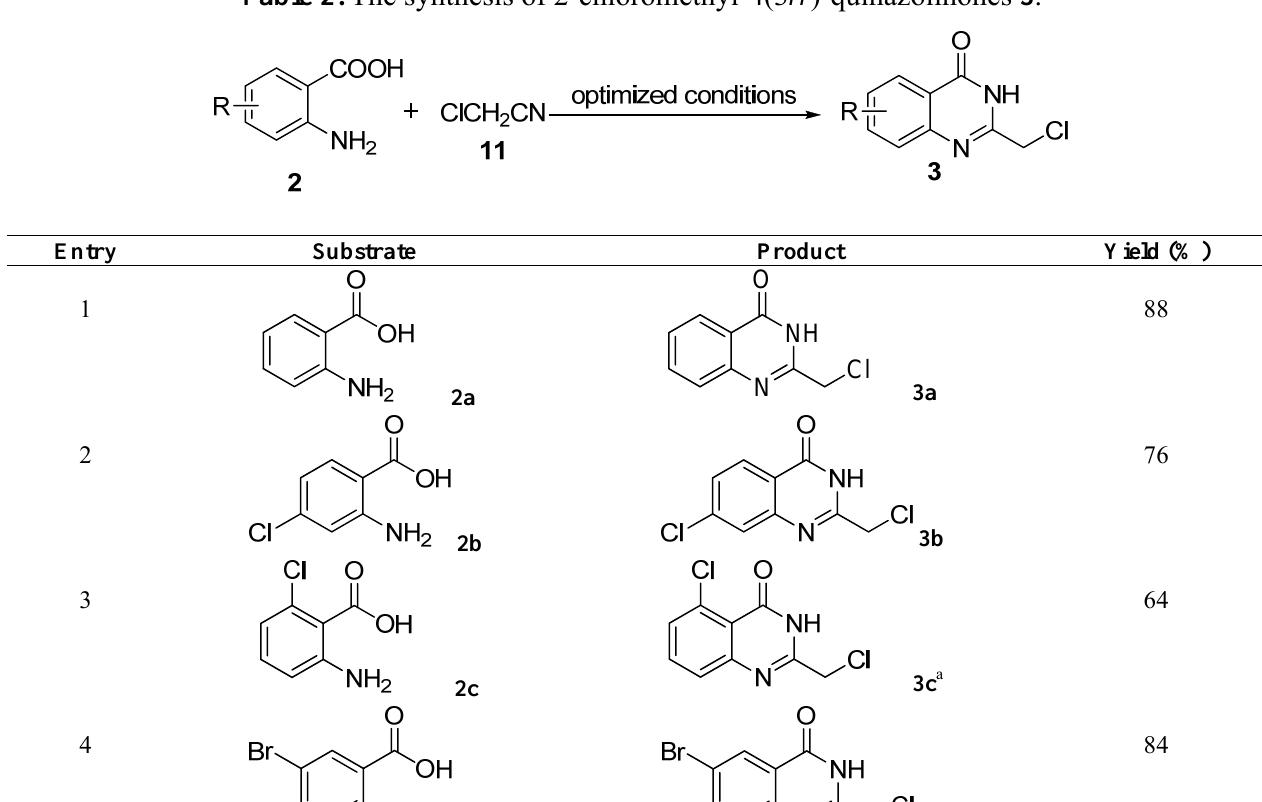
Table 2. The synthesis of 2-chloromethyl-4(3 H )-quinazolinones 3